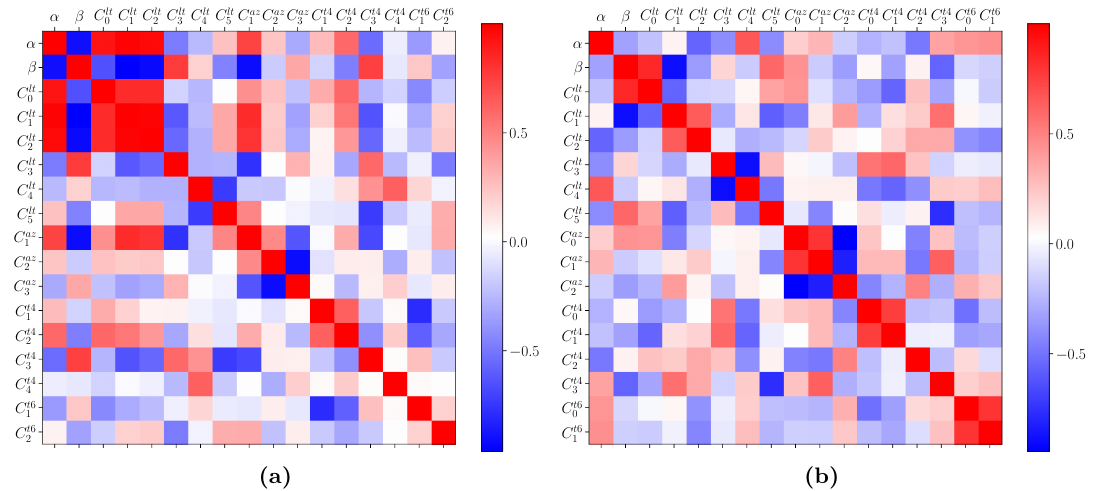
Figure 14. Parameter covariances in Jacobi polynomial fits with [ n lt , n az , n t 4 , n t 6 ] = [6342] to the real (a) and imaginary (b) components of the unpolarized reduced pseudo-ITD for z/a ≤ 12 . Entries are normalized according to Cov